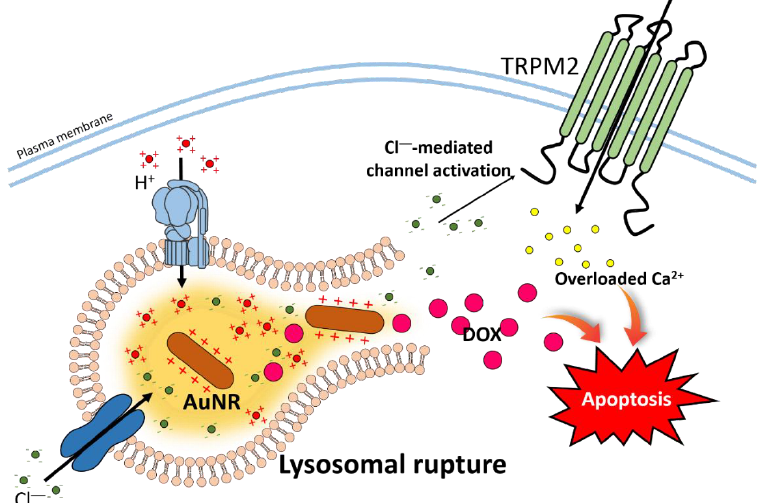
Figure 3. Schematic cartoon illustrating mechanism of AuNR-DOX-induced apoptosis. The hydrolysis of AuNR-DOX induces AuNR to reflect positive charge and triggers chloride influx into lysosomes. Continued chloride influx leads excessive activation of V-ATPase, and lysosomal swelling and rupture to release DOX and chloride to the cytoplasm. The DOX and Ca 2+ through the chloride-activated TRPM2 increase cellular apoptosis. Abbreviation: V-ATPase: Vacuolar type of H + -ATPase. Nanomaterials can act as the carrier for conventional drugs by transporting drugs or proteins through lysosomes such as AuNRs conjugated with Naja kaouthia protein toxin 1 (NKCT1) (one of the snake toxin protein) [191], silk NPs conjugated with doxorubicin (anti-cancer drugs) [192], and AgNPs conjugated with salinomycin (killing agent for cancer stem cells) [193]. These nanomaterials can maximize drug delivery to reach the lysosome easily, and, subsequently, kill the cancer cells from leukemia [191], breast cancer [192], and ovarian cancer [193]. The “small size” of NPs, which is one